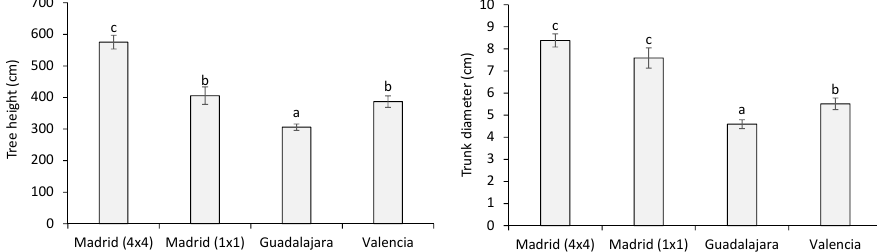
Figure 3. Tree height and diameter at the base of trunk of Ademuz elm clone measured in 4-year-old trees growing at the four experimental plots in Madrid, Guadalajara, and Valencia. Vertical bars indicate standard errors and different letters denote significant differences among plots (LSD test, p < 0.05).